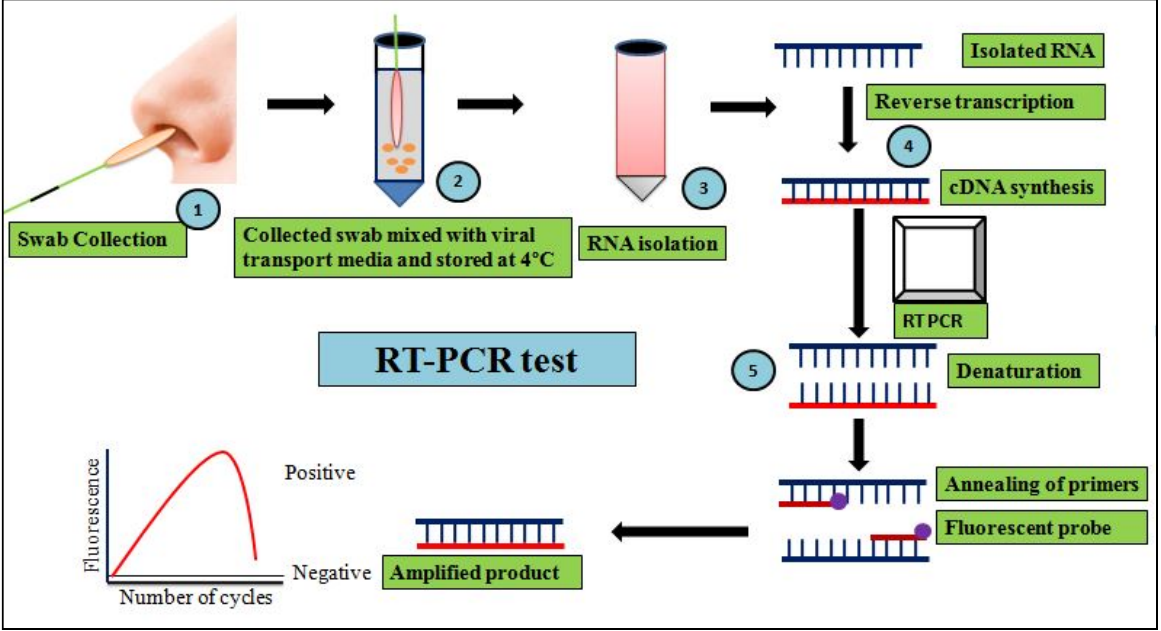
Figure 1. Flow chart of RT-PCR–based detection of SARS-CoV-2 infection: ( 1 ) collection of the test sample from anindividual;( 2 ) mixing the collected sample with viral transport media and storageat 4 °C until use;( 3 ) isolation of viral RNAs from the collected sample;( 4 ) synthesis of cDNA from viral RNA by reverse transcription;( 5 ) RT-PCR with specific primers/fluorescent markers demonstrates either positive or negative results for SARS-CoV-2 detection.